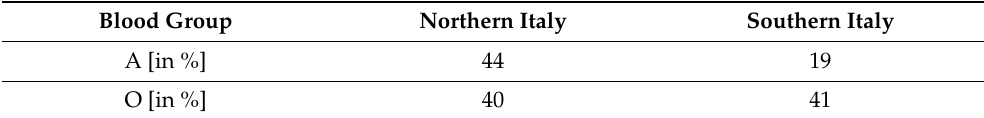
Table 2. Distribution of blood groups in Italy. Blood Group